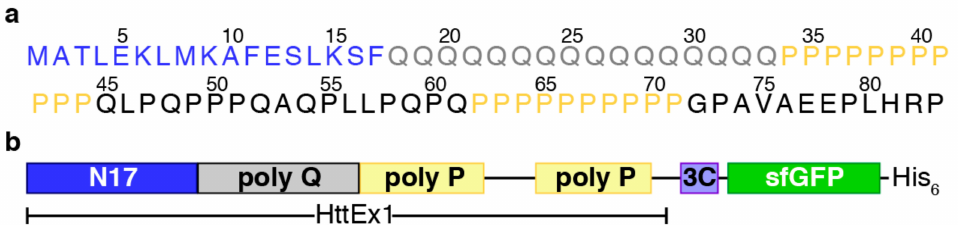
Figure 1. The huntingtin exon-1 construct used in this study. ( a ) Amino acid sequence of huntingtin exon-1 (HttEx1). Note that the numbering corresponds to an HttEx1 construct with 16 glutamines (H16). N17 and the homorepeats of glutamine and proline are colored in blue, gray and yellow, respectively. ( b ) Cartoon of the construct used in this study with HttEx1 fused to a 3C cleavage site, followed by superfolder green fluorescent protein (sfGFP) and the